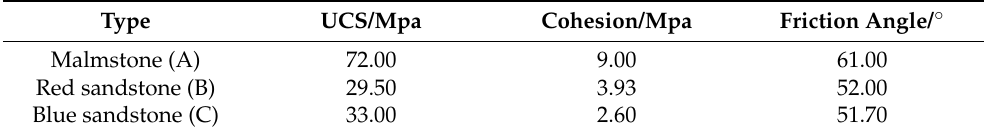
Table 1. Mechanics parameters of intact rocks.